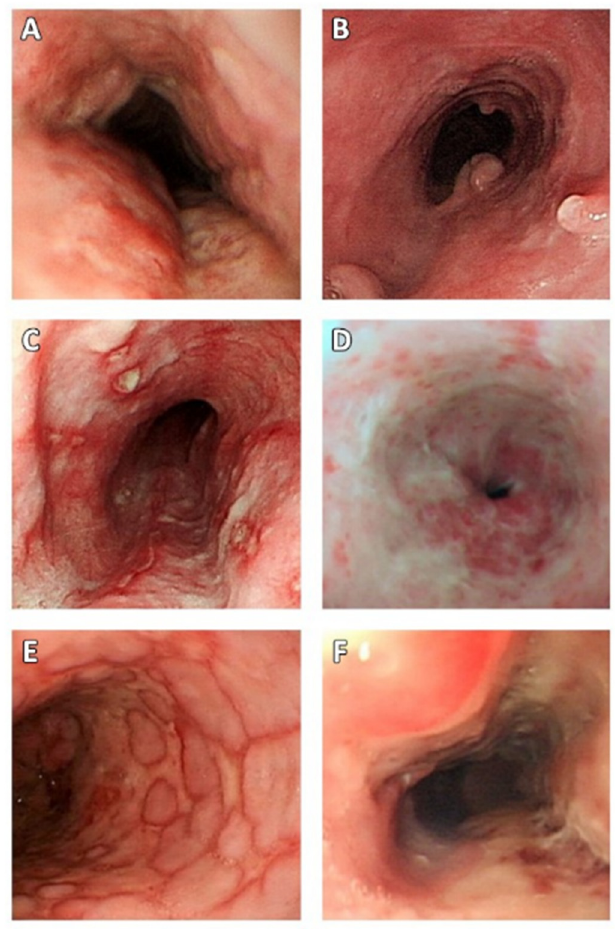
Figure 2. Endoscopic features of CMV esophagitis. ( A ) Inflammation; ( B ) polypoid lesion; ( C – F ) variable morphologies of esophageal ulcers. CMV—cytomegalovirus.